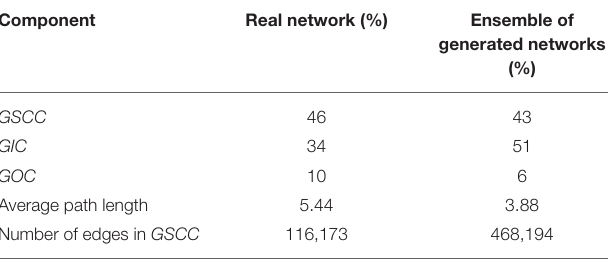
Average path length Number of edges in